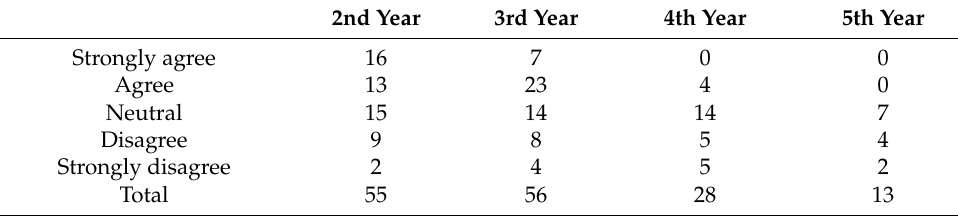
Table 4. Distribution of student responses to item no. 18 per academic year of RIPLS